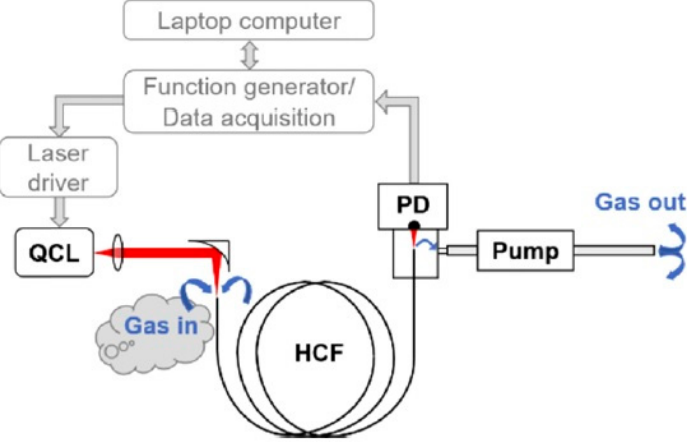
Figure 5. Experimental setup of the ARHCF-based N 2 O sensor utilizing WMS technique and a 4.54 µm QCL. Reprinted with permission from [27]. © The Optical Society. 4.54 µ m QCL. Reprinted with permission from [27]. © The Optical